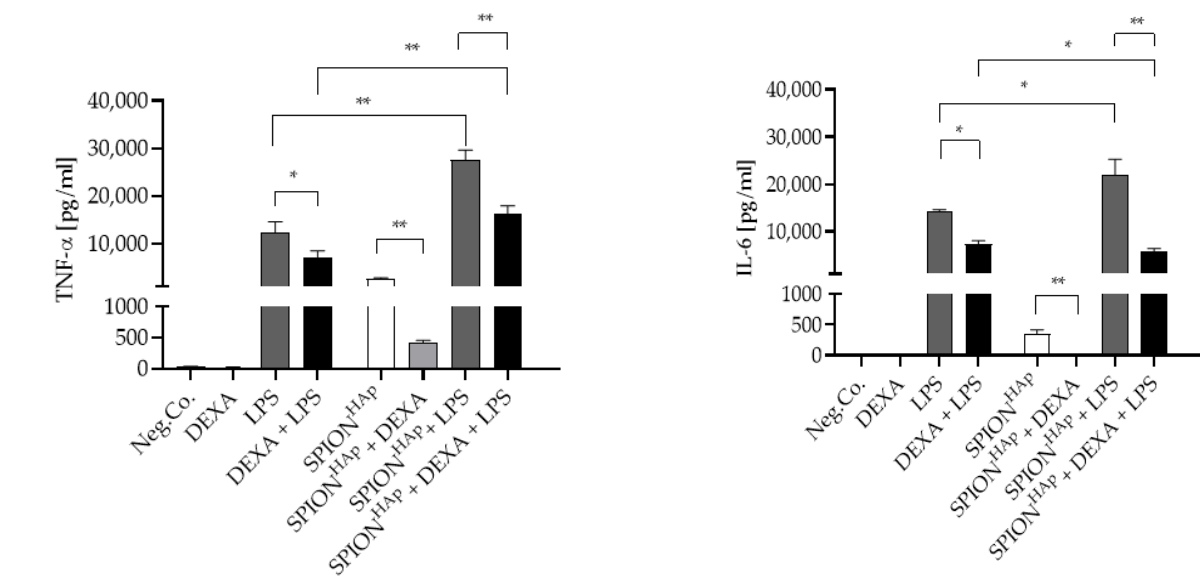
Figure 7. TNF-α and IL-6 release from murine macrophages after treatment with SPION HAp at an iron concentration of 100 µg/mL without or with dexamethasone (DEXA) and/or LPS. Neg.Co corresponds to untreated cells. Experiments were performed in triplicate. Significance between treatment groups and control at the respective time is indicated by asterisks: * p < 0.05, ** p < 0.005. p values higher than 0.05 were assumed not significant (n.s.).